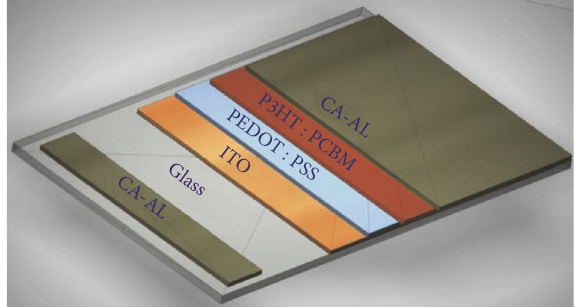
Figure 1: Organic photovoltaic cell.